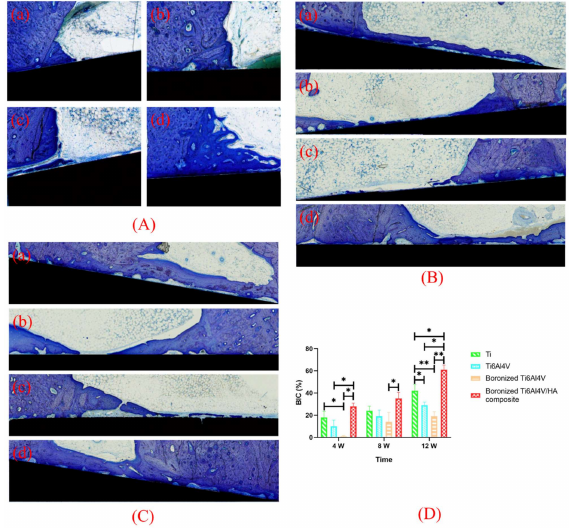
Figure 7. Toluidine blue staining of bone tissues around the different specimens at the ( A ) 4th, ( B ) 8th, and ( C ) 12th weeks after implantation: ( a ) Ti, ( b ) Ti6Al4V, ( c ) boronized Ti6Al4V, and ( d ) boronized Ti6Al4V/HA composite. ( D ) Quantitative analysis of BIC (* p < 0.05, ** p < 0.01). At the 4th week, a small amount of osteoid was formed outside the Ti implant, extending from the original cortical bone to the bone marrow cavity. An obvious inverted line was found between the newly formed osteoid and the original cortical bone, which appeared purple or blue. There was a small contact area between the osteoid and the implant. For Ti6Al4V, limited osteoid formation was observed around the implant